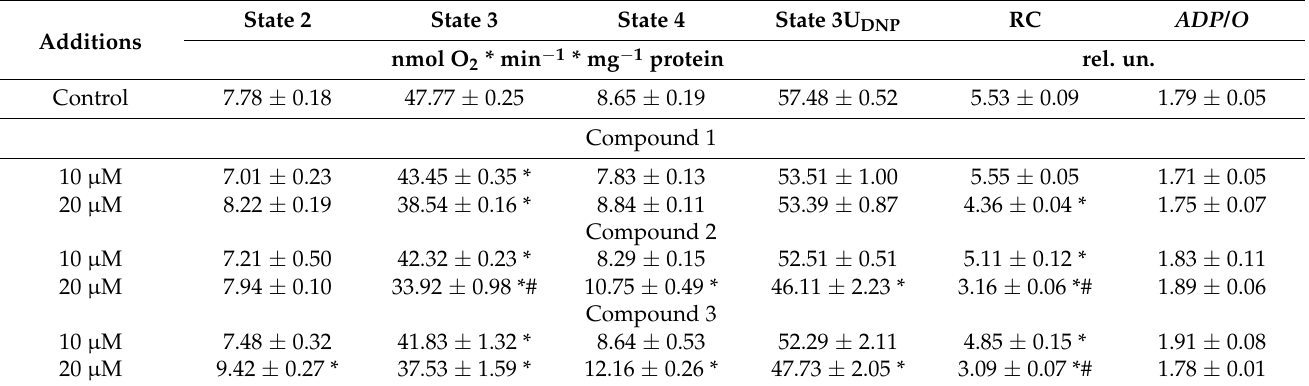
Table 2. Effects of modified levopimaric acid diene adducts on the succinate-fueled respiration of rat liver